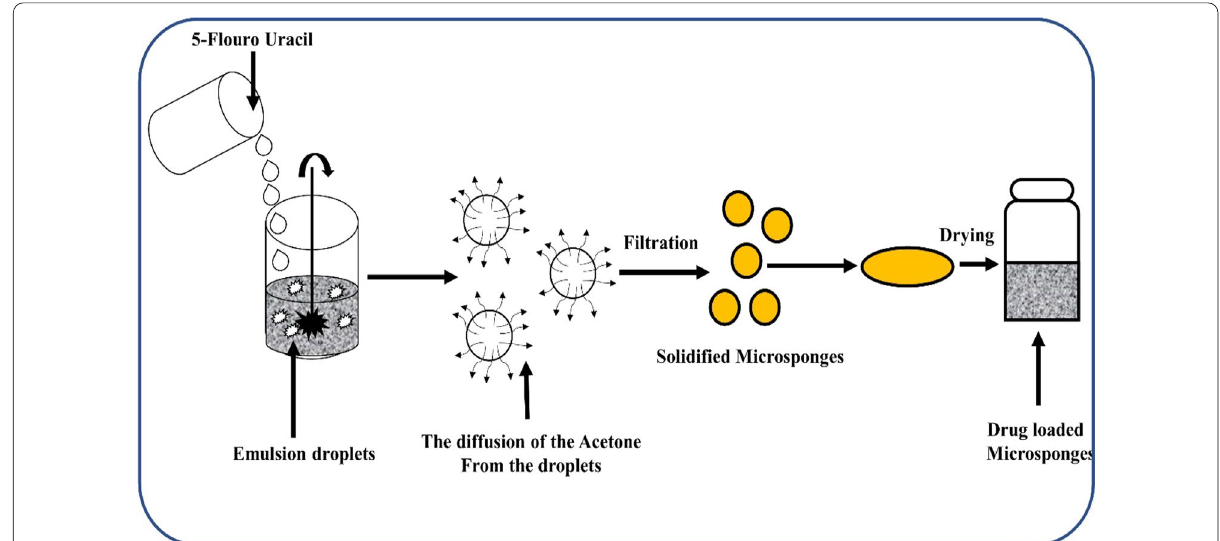
Fig. 18 Method of preparation of 5-FU microsponges in colon